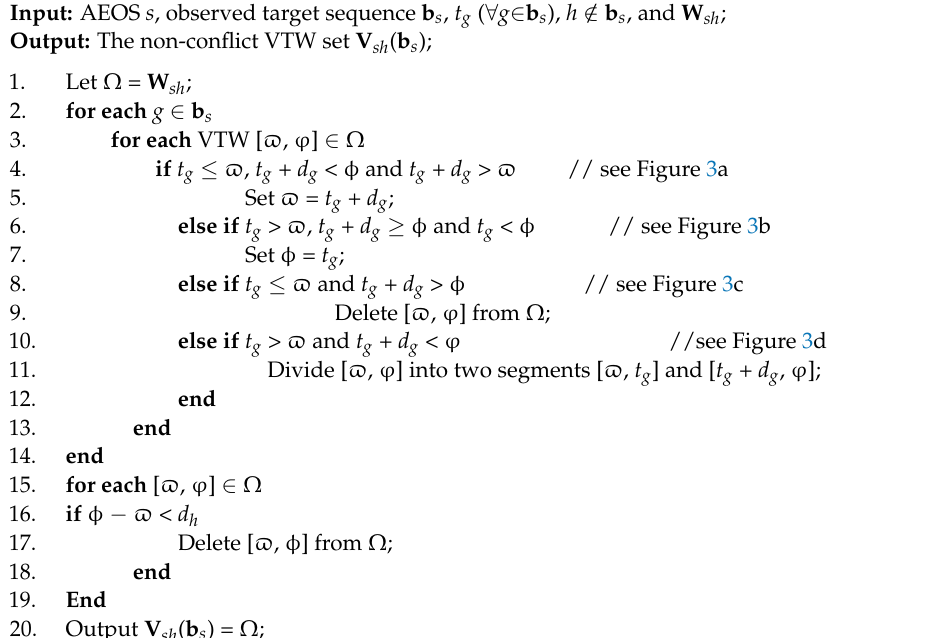
Algorithm 1: Compute non-conflict VTWs